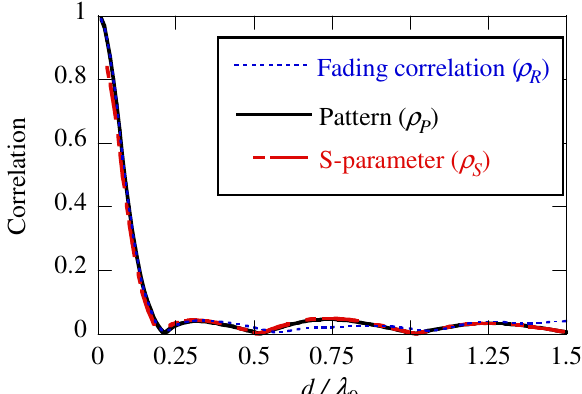
Figure 9. Correlation coefficient versus element spacing d : dipole array( M =